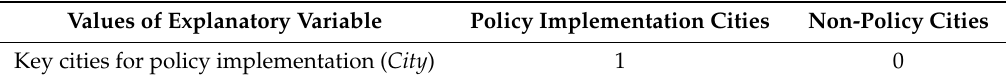
Table 3. Values of the explanatory variable City .